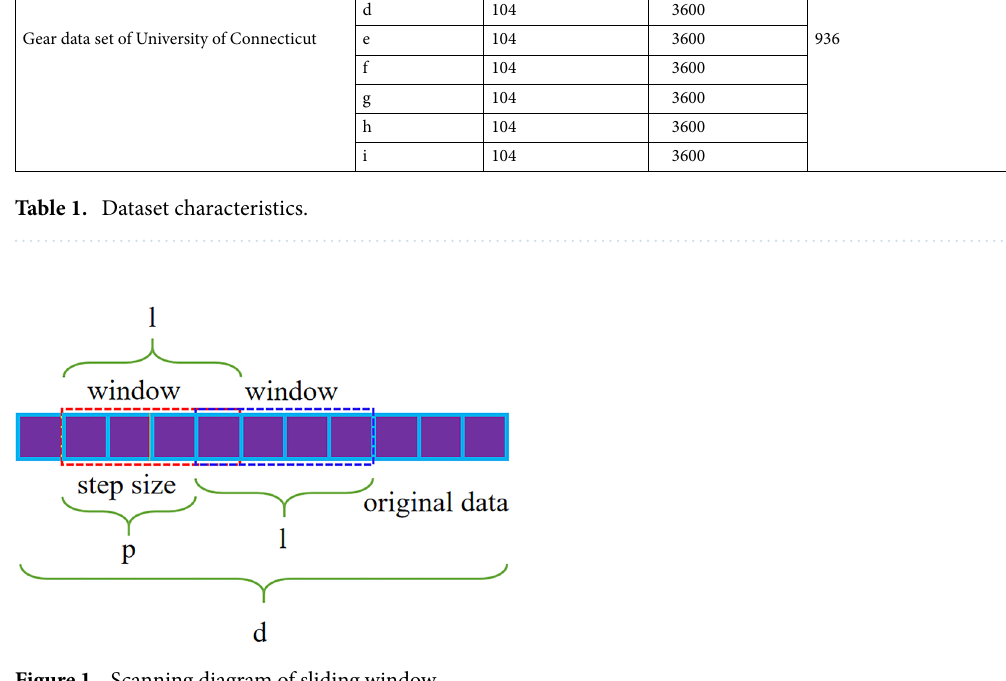
Figure 1. Scanning diagram of sliding